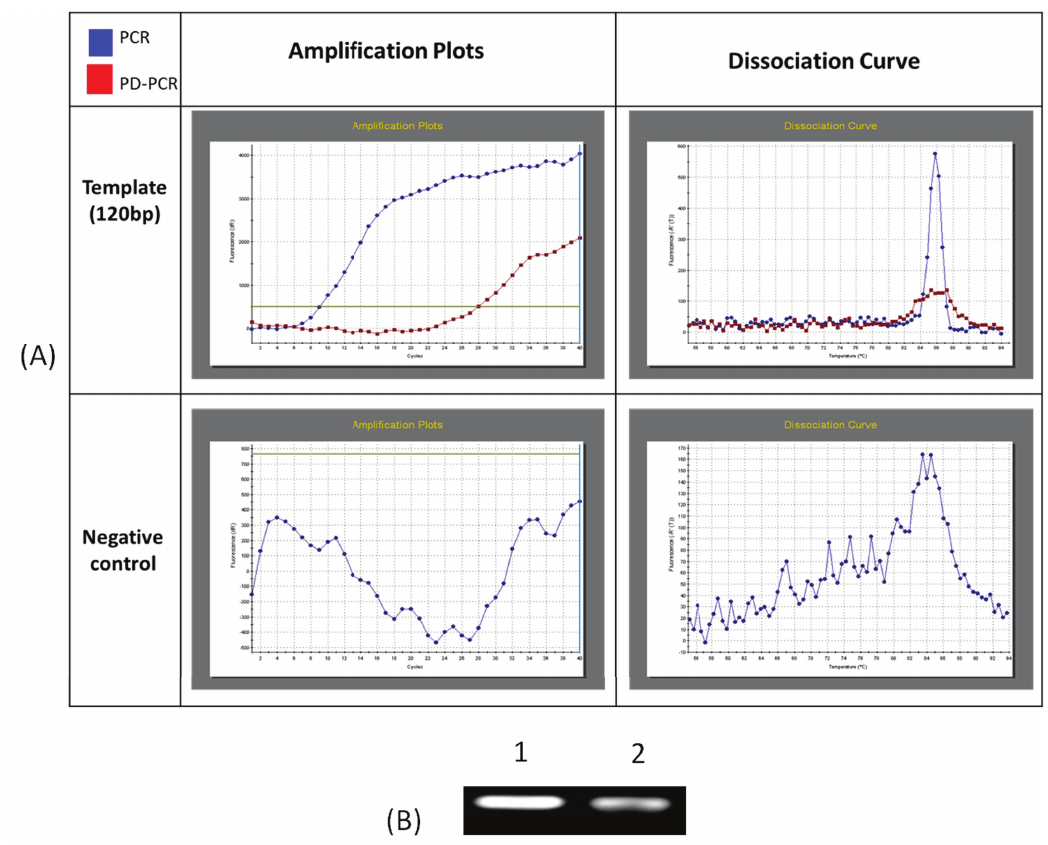
Figure 6. Real time PCR and PD-PCR ( A ) show ampliflication plot and dissociation curves obtained after real time PCR analysis of amplification of 120 nucleotides single stranded template DNA via conventional PCR and PD-PCR. In control reaction no template DNA was added. ( B ) PCR products obtained in real time PCR were also run on agarose gel and visualised on gel doc system. Data